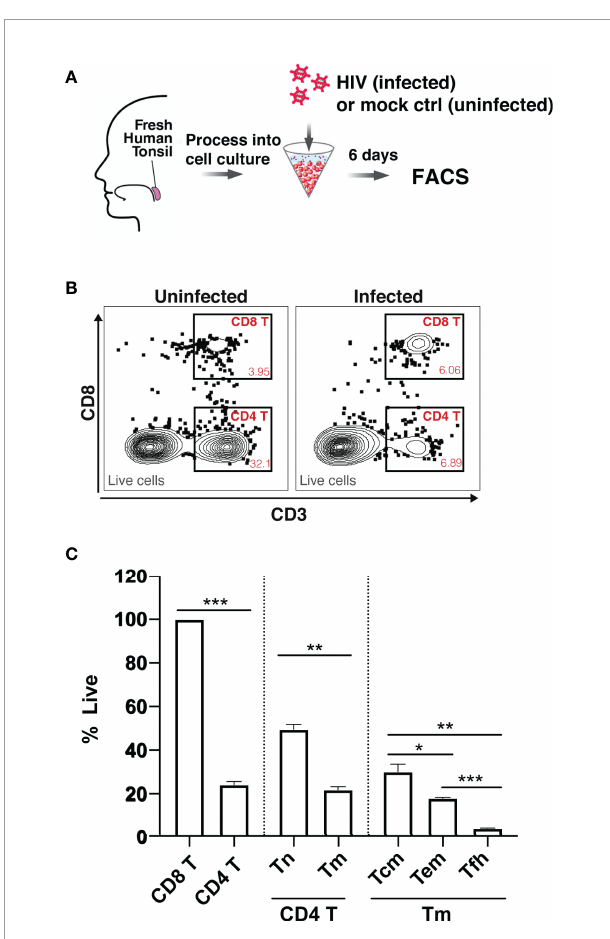
FIGURE 1 | Preferential death of CD4 T cells in tonsil HLAC specimens infected ex vivo with HIV. (A) Schematic of the HLAC collection and ex vivo infection. Fresh human tonsil cells were mock-treated or infected with HIV.GFP by spinoculation. Six days later samples were harvested for analysis by FACS. (B) Gating to identify CD8 T (CD8+CD3+), CD4 T (CD8- CD3+) in infected cultures (right) and uninfected control culture (left). Preceding parent gates are indicated at the lower left corner. Numbers correspond to percentages of cells in the indicated gate. Data for this one donor is representative of the 6 donors. (C) Quanti fi cation of CD4 T Naive (Tn), CD4 T memory (Tm), and CD4 T memory subsets including central memory (Tcm), effector memory (Tem), and T follicular helper (Tfh) cells, as identi fi ed by sequential gating (see Figure S1 ). For each subset, the percentage of live cells relative to uninfected control (% live) is shown. Data were normalized to CD8 T cell counts (details described in Materials and Methods). The data represent mean +SD of an experiment performed in triplicate. These data represent 6 donors studied in 3 independent experiments. *p ≤ 0.05; **p ≤ 0.01; ***p ≤ 0.001; no label: not signi fi cant , p > 0.05. Signi fi cance was measured by paired Student ’ s T